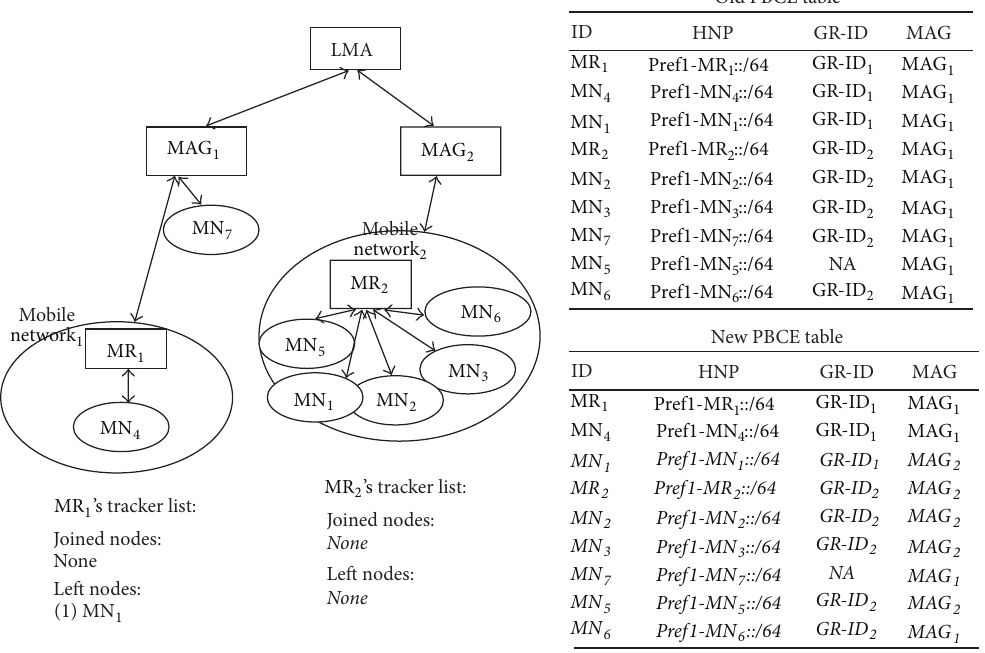
Figure 8: Updated PBCE and mobile network’s new tracker